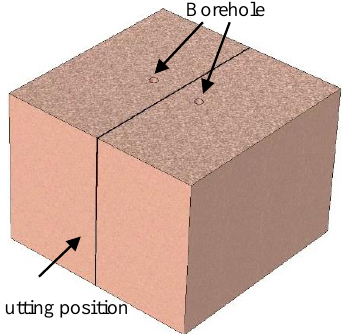
Figure 6. Specimen cutting diagram.